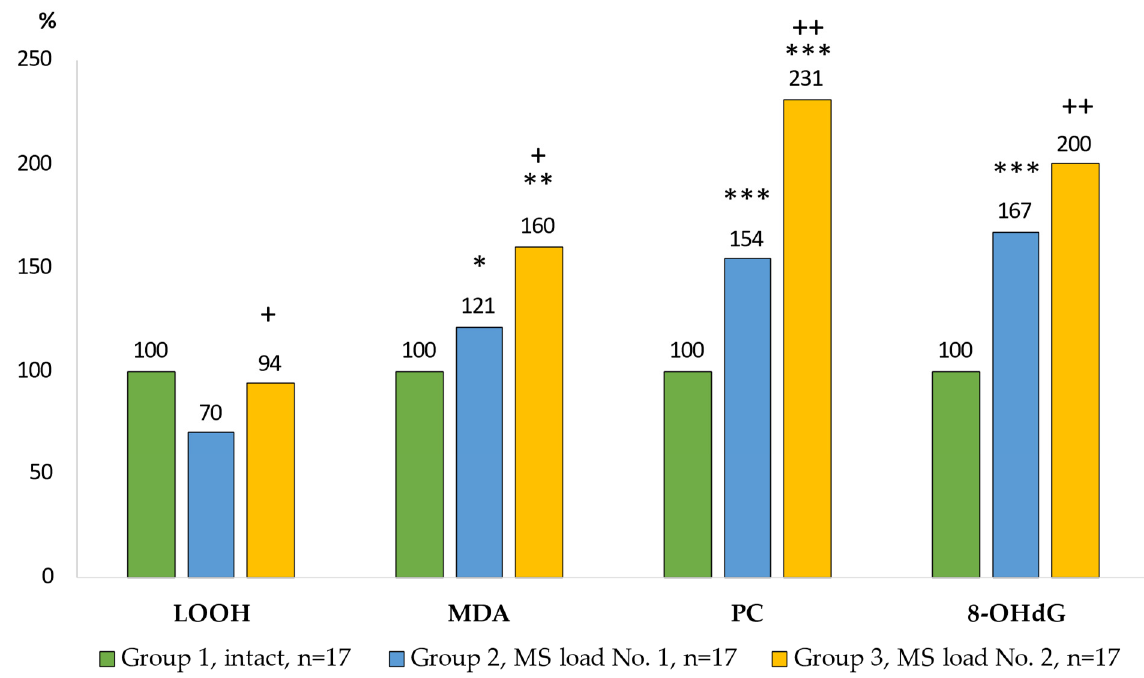
Figure 4. Indicators of peroxidation in the culture medium of AM. Notes: statistical significance relative to Group 1: *— p < 0.05; **— p < 0.01; ***— p < 0.001; relative to Group 2: +— p < 0.05; ++— p < 0.01.